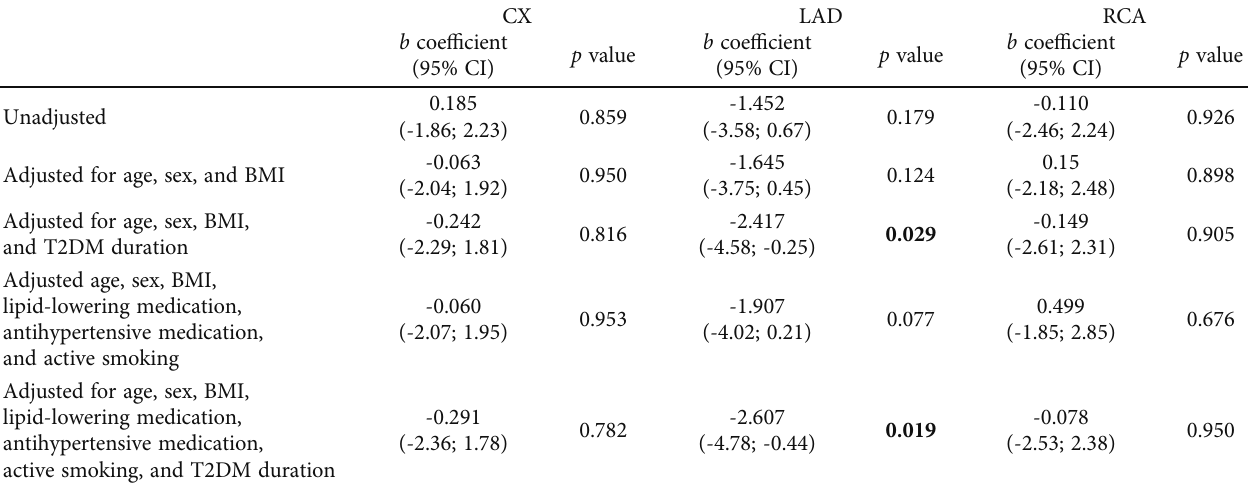
Table 3: Multiple linear regression: unadjusted and adjusted di ff erences in PCAT attenuation between Lira+ and Lira- for each coronary